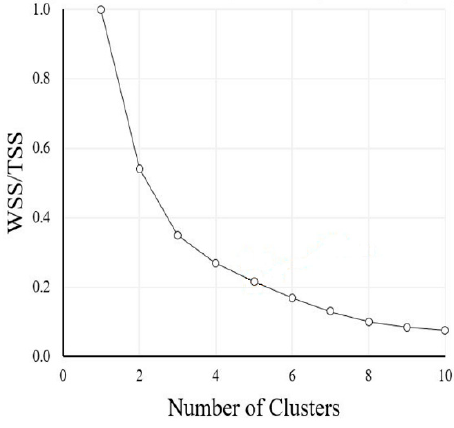
Figure 5. Elbow criterion analysis.